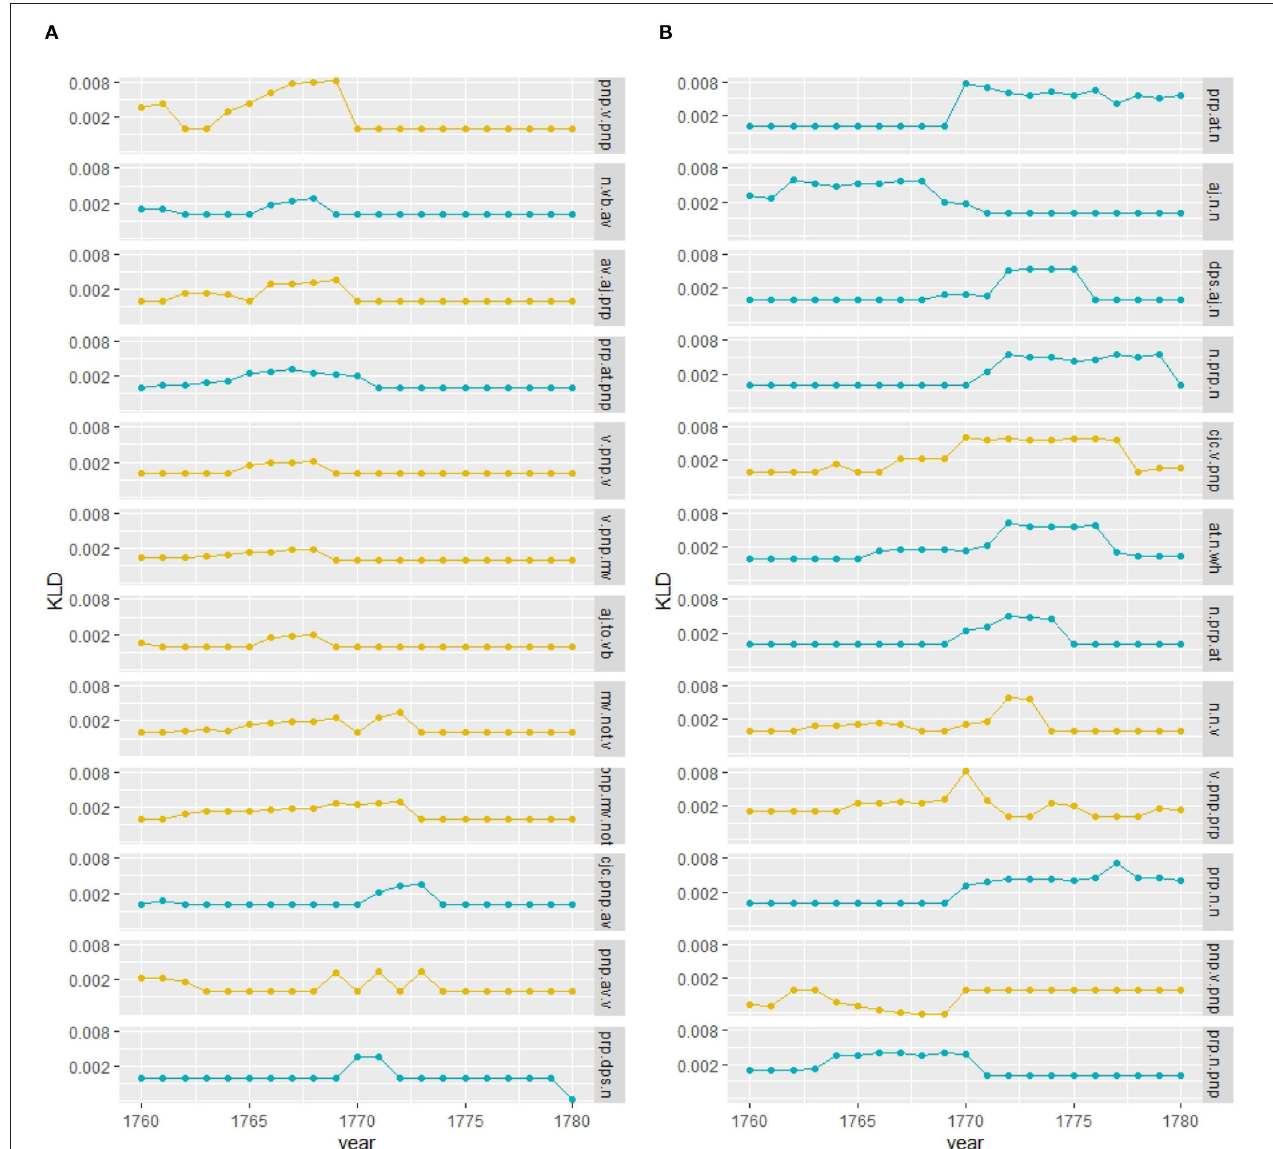
FIGURE 10 | Features contributing to period of change (from top to bottom showing highest to lowest contribution; blue: nominal trigrams, yellow: verbal trigrams)—contemporary model women vs. men (pos-trigrams). (A) Women. (B) Men. aj, adjective; av, adverb; cjc, conjunction; at, determiner; mv, modal verb; n, noun; dps, possessive s /pronoun; prp, preposition; pnp, pronoun; v, verb; vb, verb be ; wh,